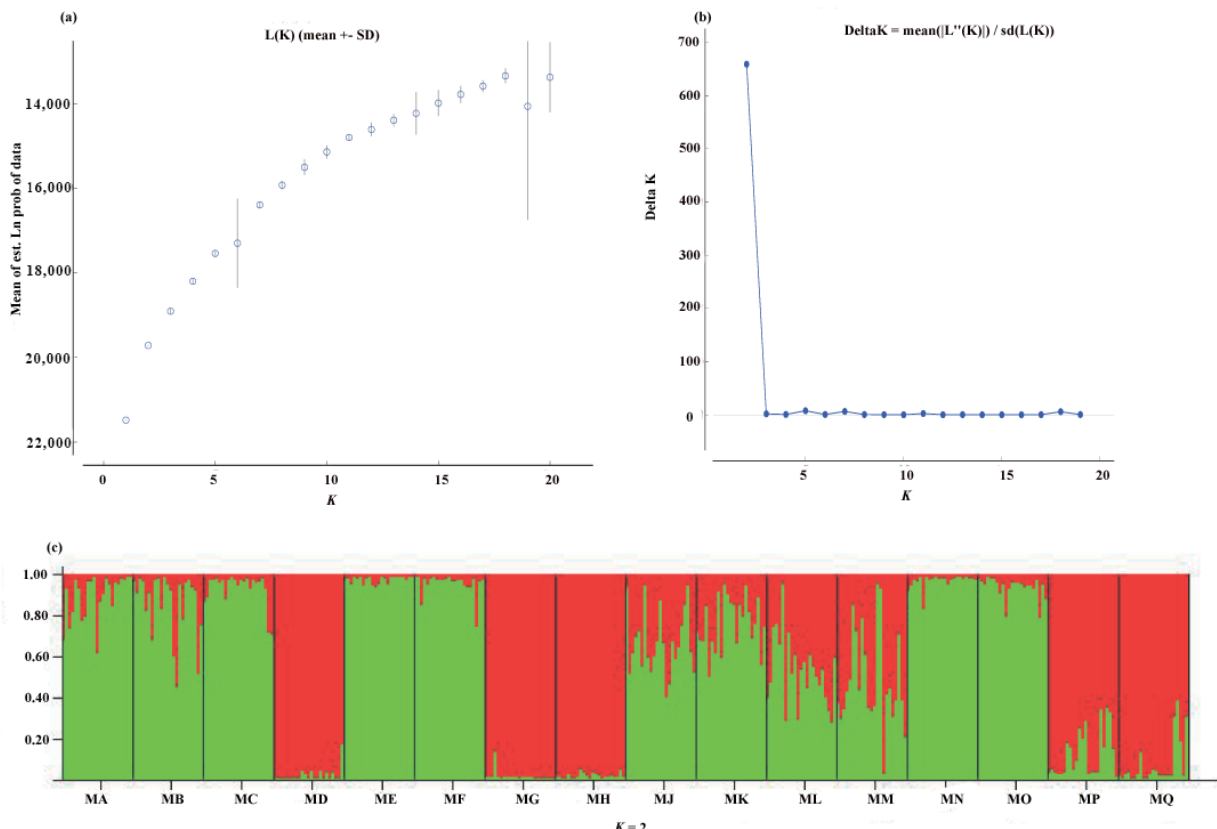
Figure 2. STRUCTURE analysis for the 16 population of P. persica : ( a ) mean of log-likelihood values [ L ( K )] for each value of K in P. persica ; ( b ) the true K values determined using the Δ K method; ( c ) assignment of all individuals into two genetic clusters based on the STRUCTURE.